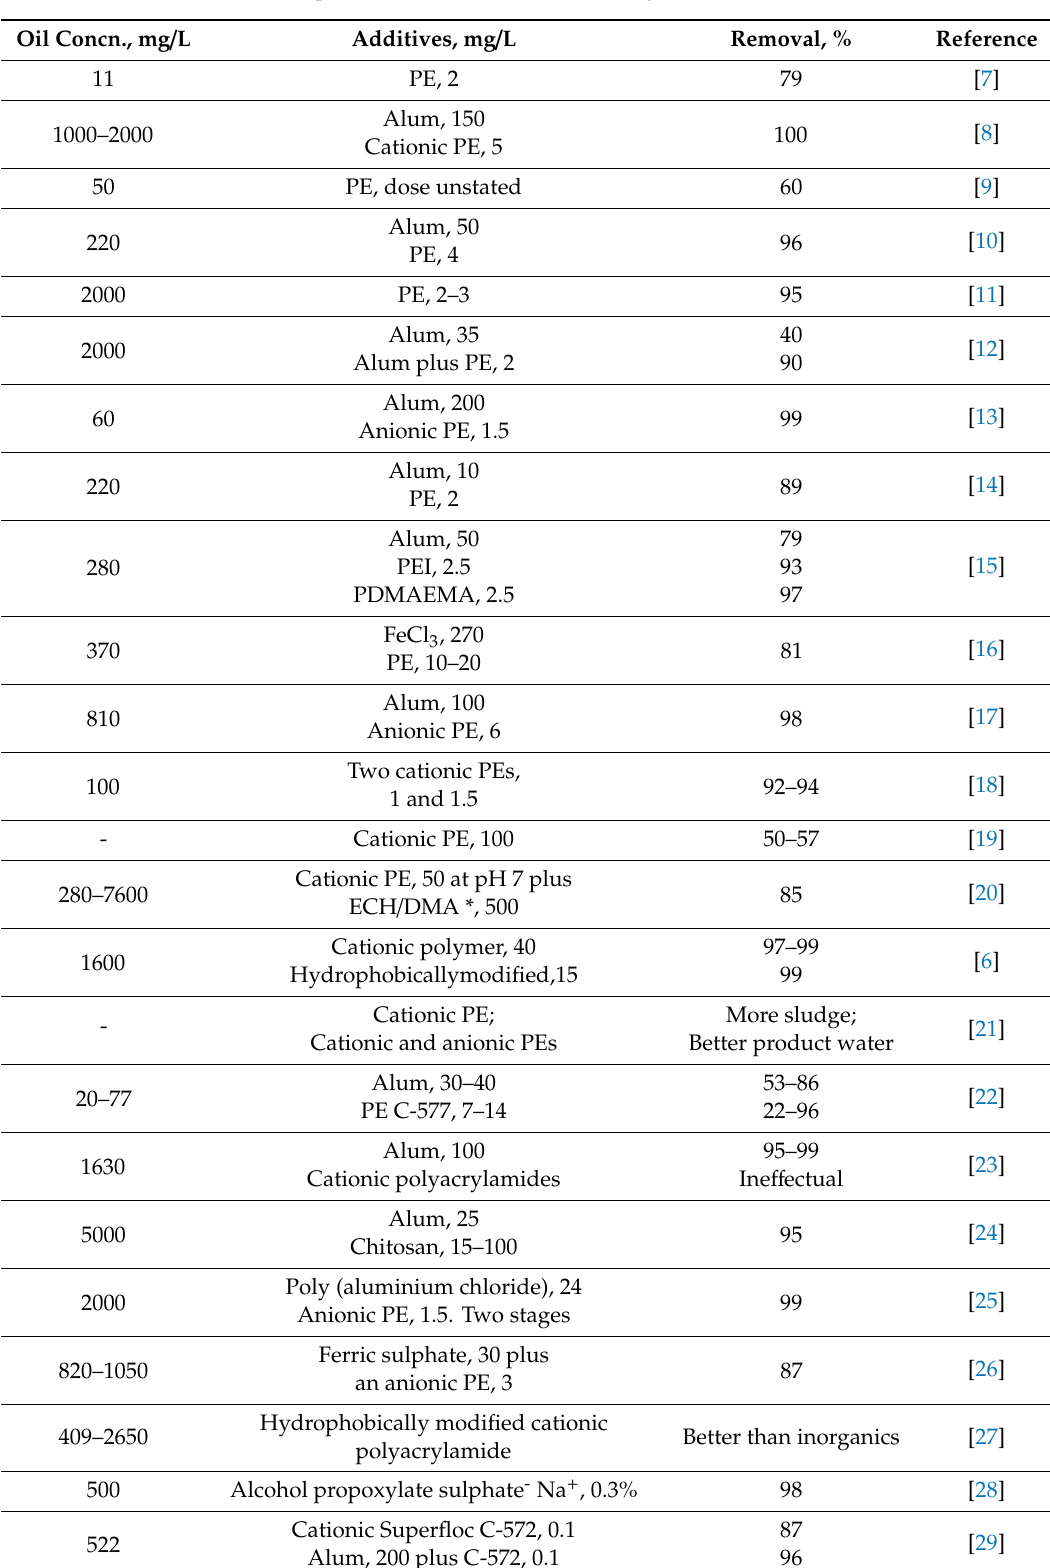
Table 1. Separation of oil from wastewater by flotation